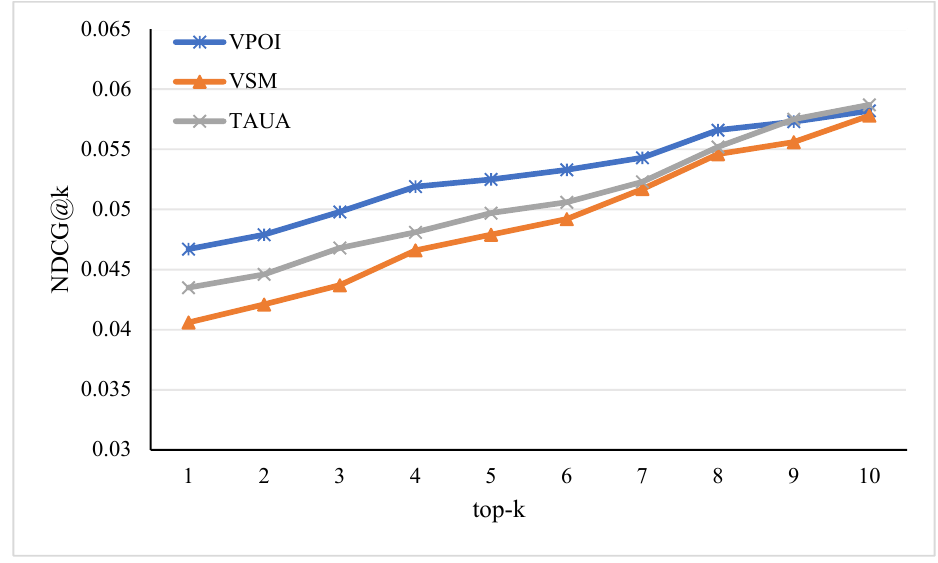
Figure 8. Top-k image recommendations NDCG@k performance comparison on Flickr datasets.